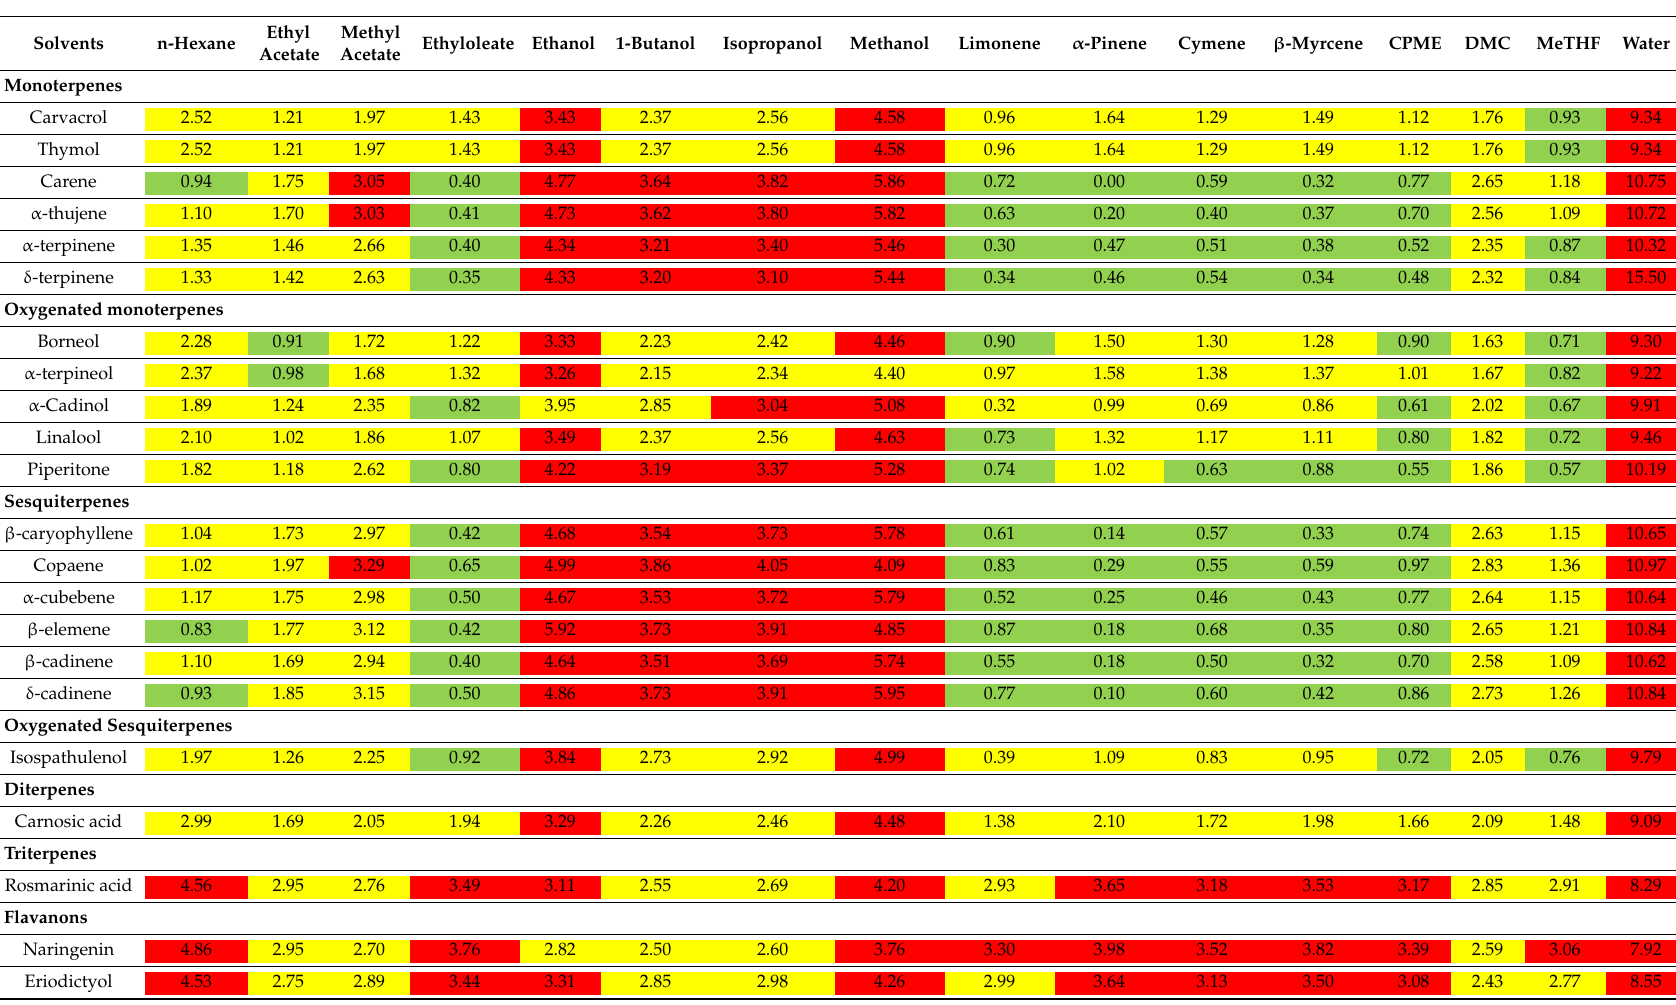
Table 1. Relative energy di ff erence (RED) results by Hansen solubility parameters (HSPs) of bioactive compounds from wild thyme for green solvents in comparison with